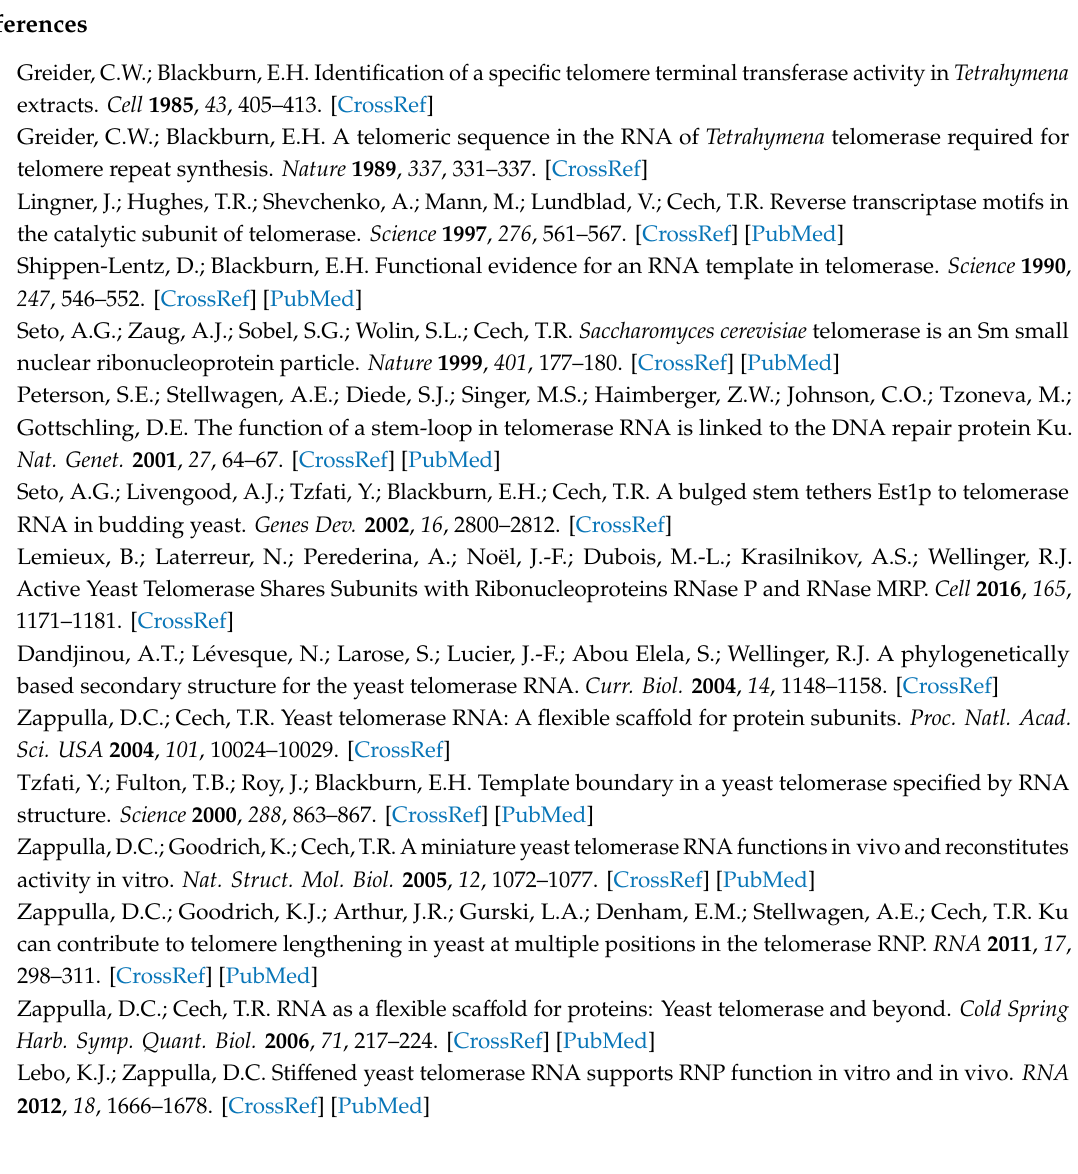
Figure S1: Mfold software prediction for the secondary structure of NNS-terminated TLC1 (nucleotides 1–1195); Figure S2: Mfold software predictions for the secondary structures of repositioned Sm-binding